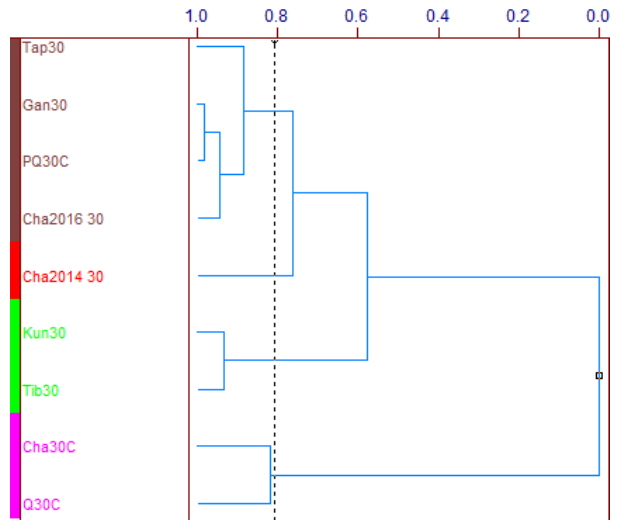
Figure 2. Dendrograms of HCA analysis performed using SNV transformed NIR spectra of waters acquired at 30 ° C. The nine different waters were classified into 4 groups based on the similarities in the spectral characteristics. The similarity between thus found clusters was 0.8.